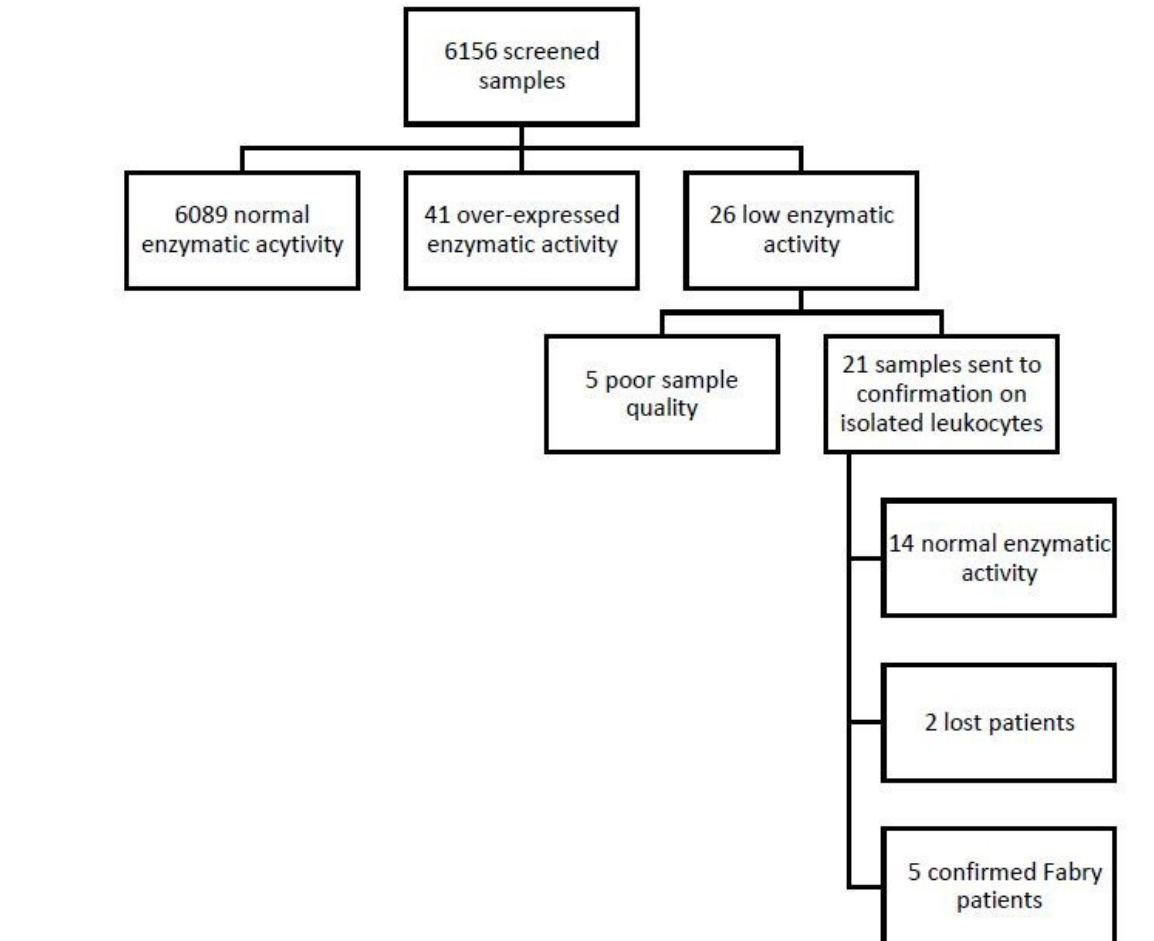
Figure 1. Screening